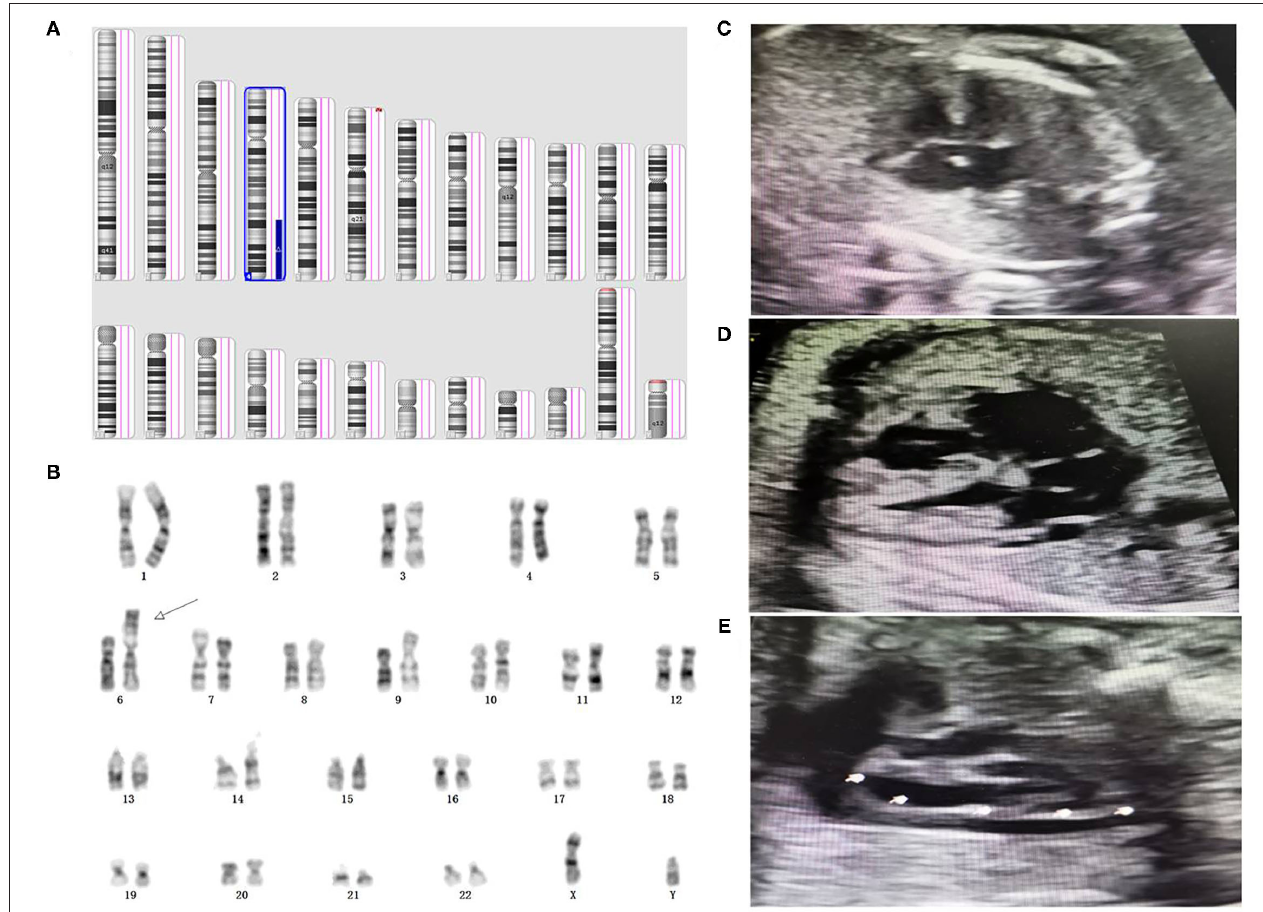
FIGURE 1 | Genetic diagnosis and ultrasound phenotype of derivative chromosome 6. (A) SNP array result indicated a 4q28.3q35.2 duplication associated with 6p25.3p25.2 deletion in the fetus. (B) Karyotype analysis indicated a derivative chromosome 6 in the fetus. (C–E) prenatal ultrasound detection indicated atrioventricular septal defect, coronary sinus dilation, and persistent left superior vena cava in the fetus,